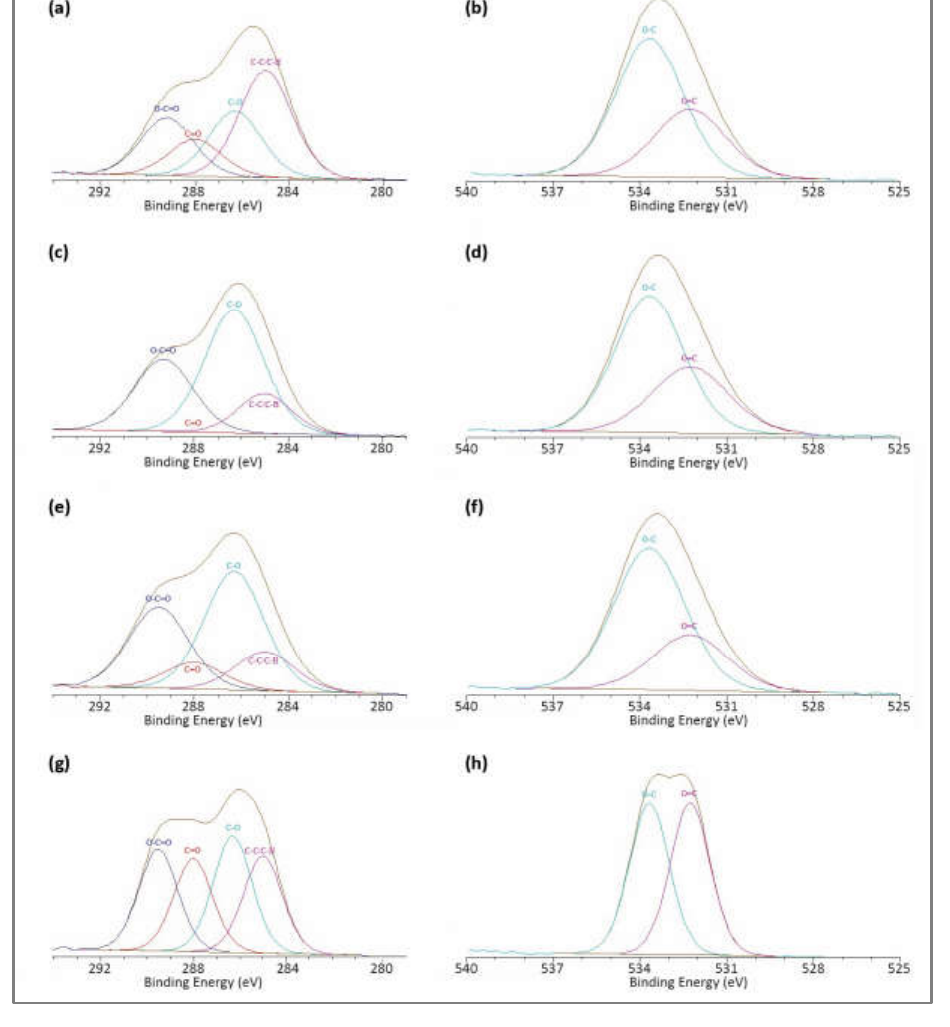
Figure 6. Carbon and oxygen XPS signals of PLA films: ( a ) Cls peaks of untreated film, ( b ) Ols peaks of untreated film, ( c ) Cls peaks of 50% O 2 + 50% Ar plasma treated film, ( d ) Ols peaks of 50% O 2 + 50% Ar plasma treated film, ( e ) Cls peaks of 100% Ar plasma treated film, ( f ) Ols peaks of 100% Ar plasma treated film, ( g ) Cls peaks of 100% O 2 plasma treated film, ( h ) Ols peaks of 100% O 2 plasma treated film. Table 1. Various components (in area %) of Cls and Ols peaks of XPS spectra of PLA films un- treated and plasma treated with different gas compositions.